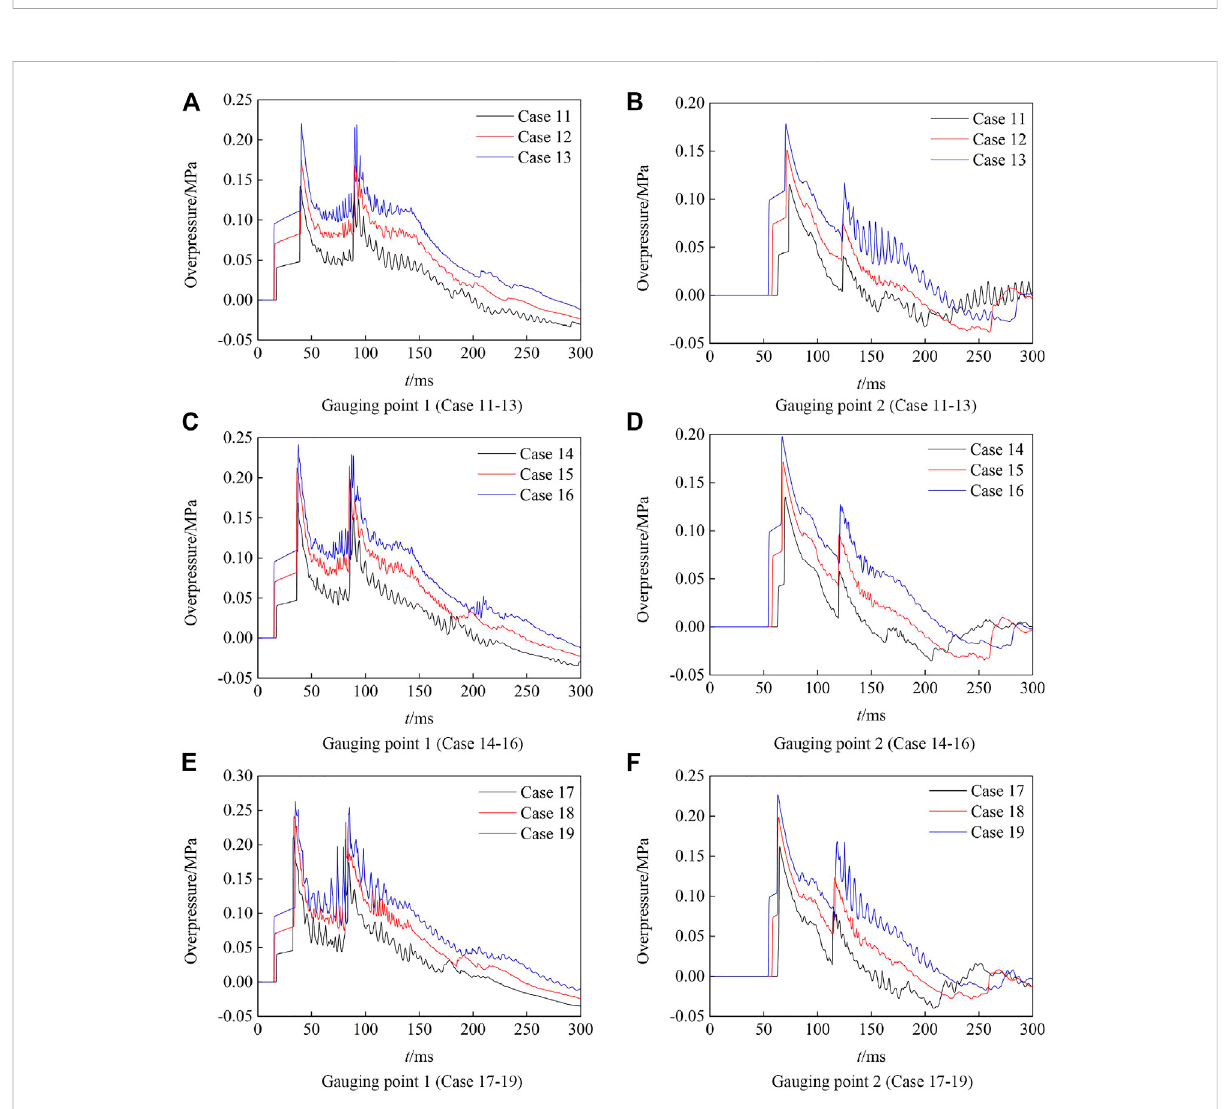
Overpressurehistorywiththecombined-drivenmethod. (A) Gaugingpoint1(Case11 – 13). (B) Gaugingpoint2(Case11 – 13). (C) Gaugingpoint1 (Case 14 – 16). (D) Gauging point 2 (Case 14 – 16). (E) Gauging point 1 (Case 17 – 19). (F) Gauging point 2 (Case 17 –